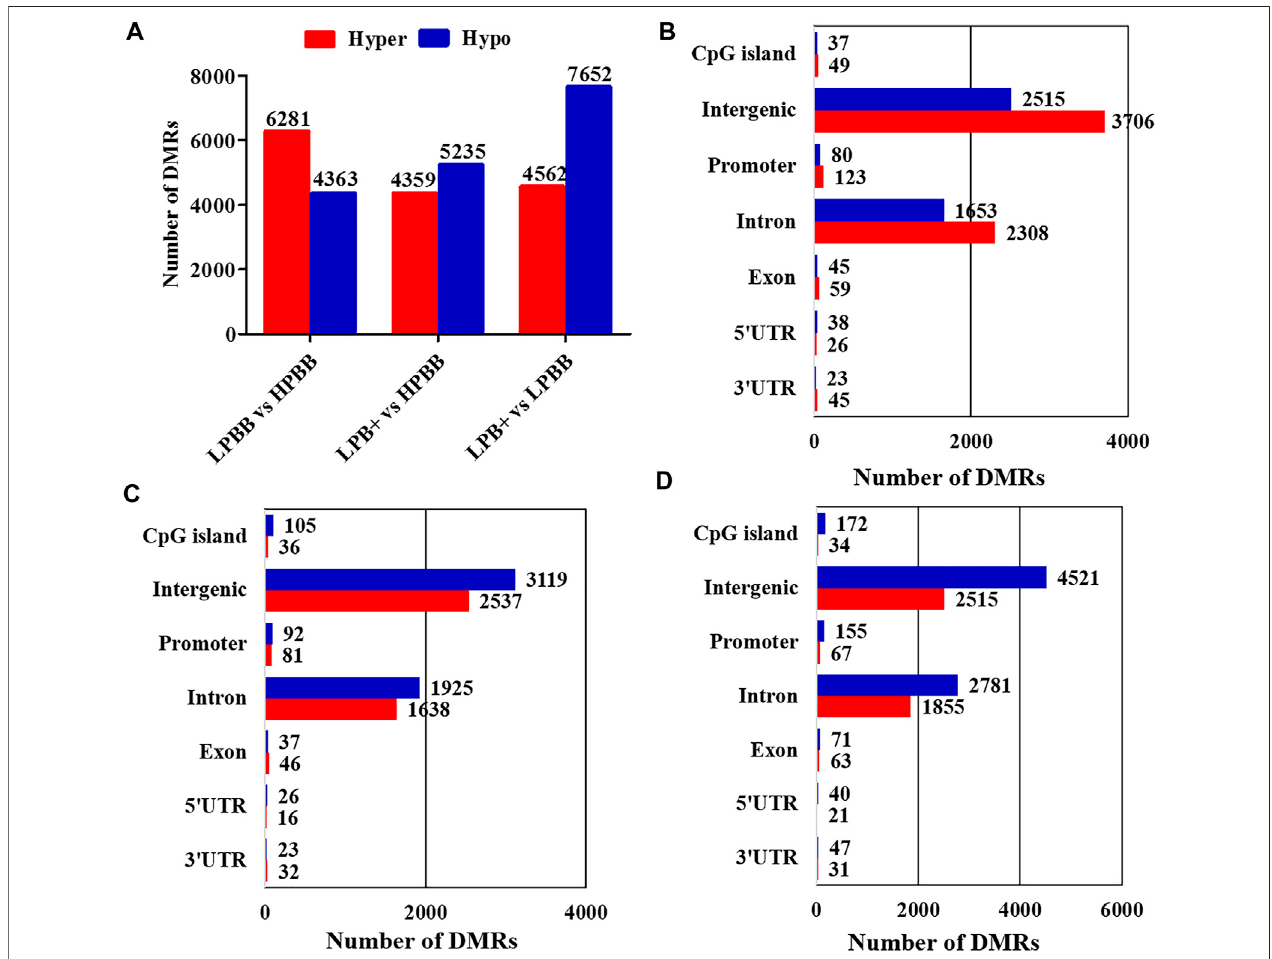
FIGURE 2 | Identi fi cation of DMRs in different groups. (A) The number of DMRs (hyper- and hypo-methylated) in different comparison groups. (B,C) The distribution of DMRs in different genomic elements in the (B) LPBB vs. HPBB, (C) LPB + vs. HPBB, and (D) LPB + vs. LPBB groups.